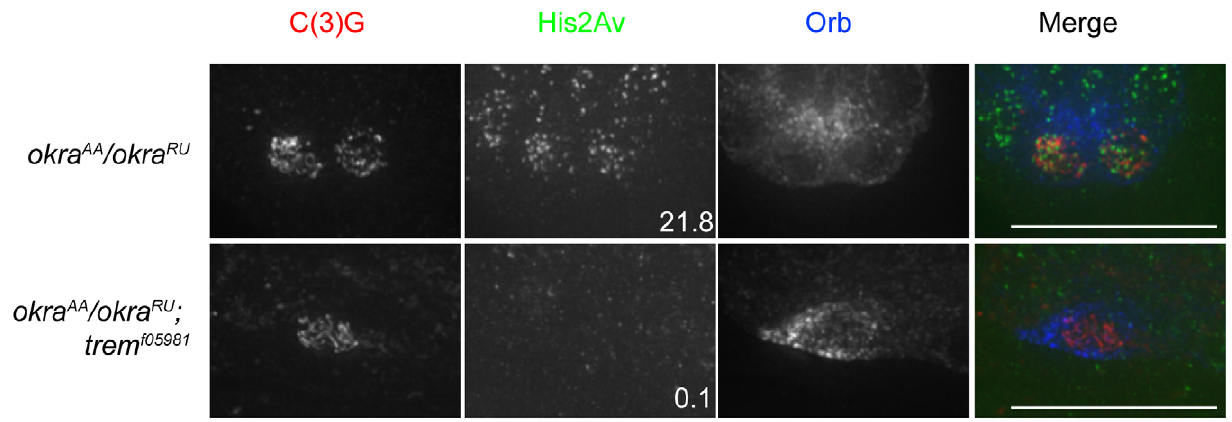
Figure 5. trem f05981 females fail to accumulate any DSBs in region 3 in the absence of DNA repair. Using an antibody to c -His2Av, okra AA / okra RU ; trem f05981 females fail to accumulate any DSBs in region 3 (average 0.1 compared to 21.8 for okra AA /okra RU ). Images are maximum intensity projections of deconvolved Z-series through the pro-oocytes in region 3 of the germarium. Stage of oocyte was determined by position and shape of cyst within the germarium, and the pro-oocyte(s) was identified by staining with antibodies to C(3)G and Orb. okra AA /okra RU ; trem f05981 females were able to rescue the two-oocyte phenotype associated with okra AA /okra RU indicating that the pachytene checkpoint is not activated in the absence of Trem (see Discussion). Scale bar, 15 m